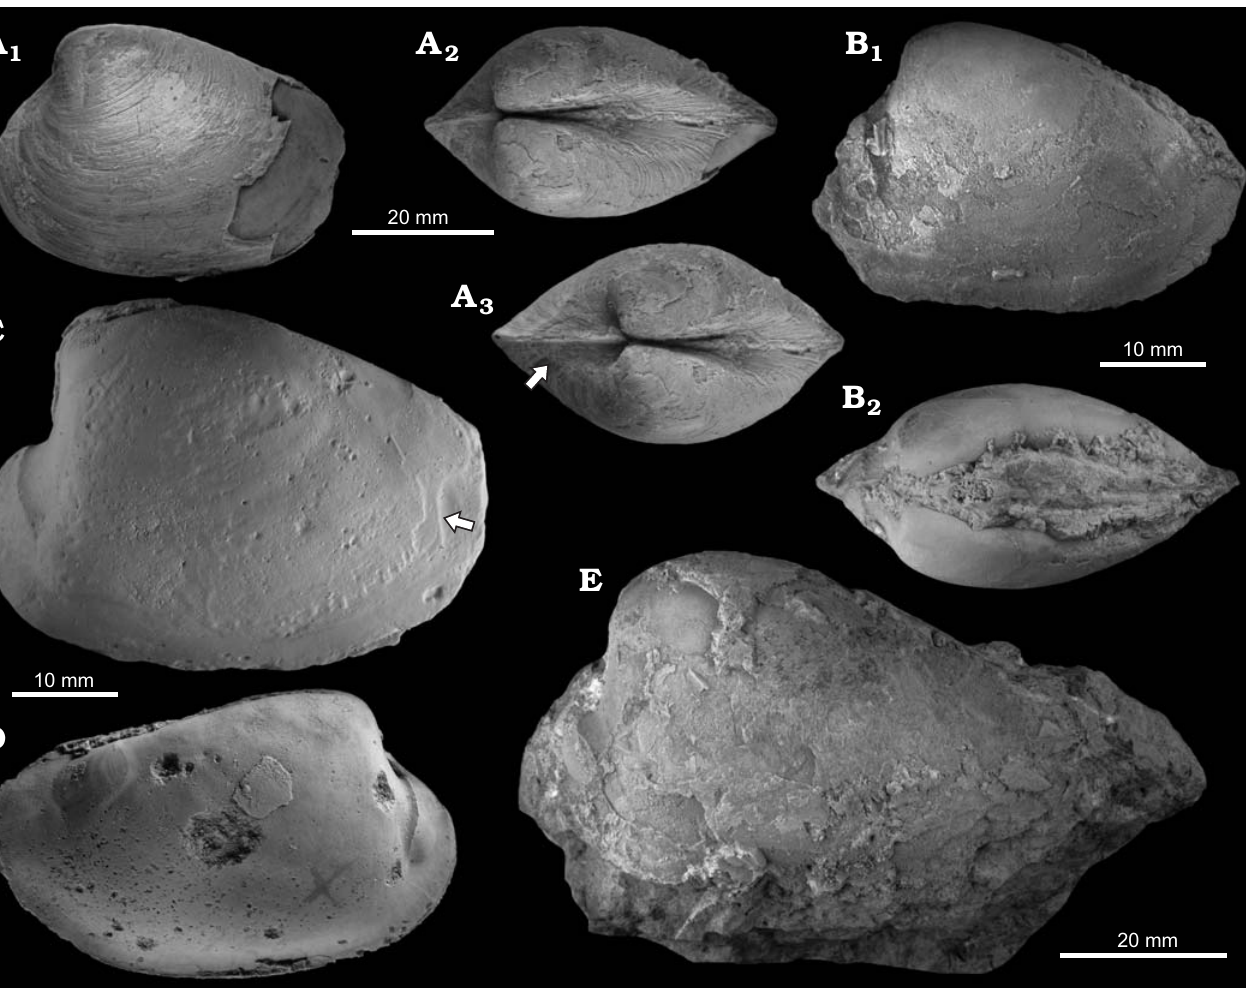
Fig. 8. The vesicomyids “ Vesicomya ” tschudi Olsson, 1931 (A–C, E) and “ Vesicomya ” ramondi Olsson, 1931 (D), from early Oligocene seep deposits in the Talara Basin, northern Peru. A . Small specimen (NRM Mo187029) from Cerro La Salina block 1, view on left valve (A 1 ), dorsal view (A 2 ), view on antero dorsal side showing lunular incision (A 3 , arrow). B . Medium-sized specimen (NRM Mo187030) from Cerro La Salina block 5, view on left valve (B 1 ) and dorsal view (B 2 ). C . Holotype (PRI 1965) from Pajarabobo, view on left valve showing posterior end of pallial line (arrow). D . Holotype (PRI 1962) from Pajarabobo, view on right valve. E . Large left valve (NRM Mo187031) from Cerro La Salina block 5, view of the outer